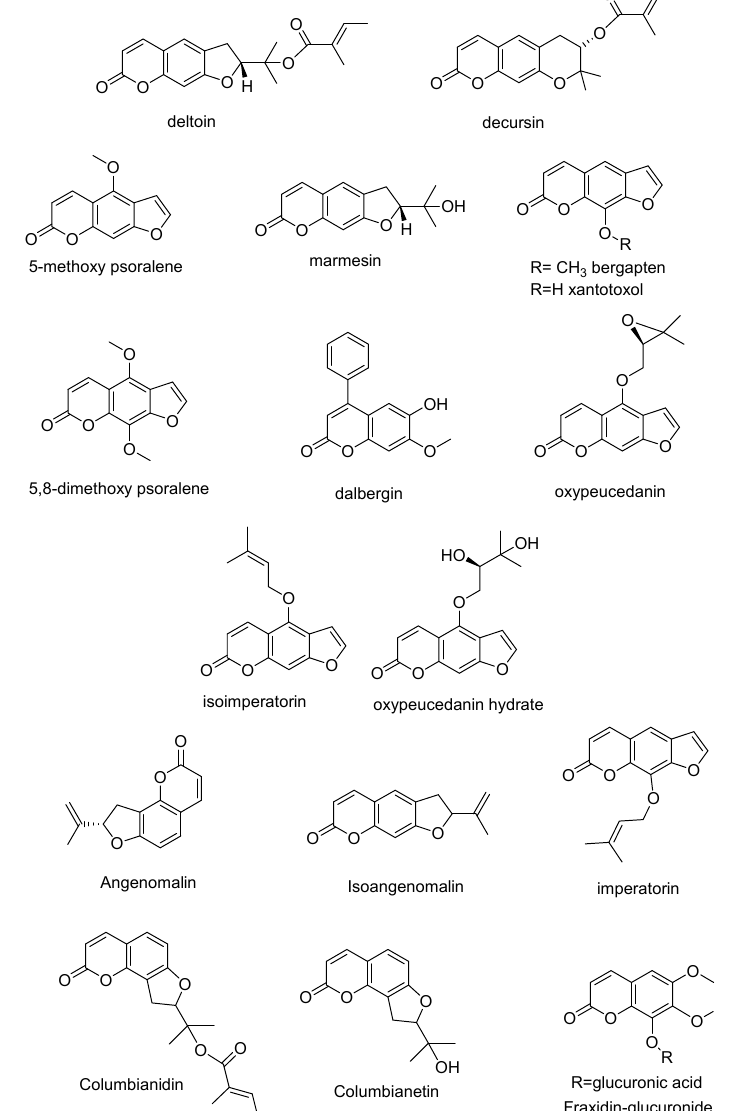
Figure 4. Chemical structures of coumarins identified in the extracts. Table 2. NMR assignments of the main constituents detected in the methanol extract of S. hedys- aroides aerial part.